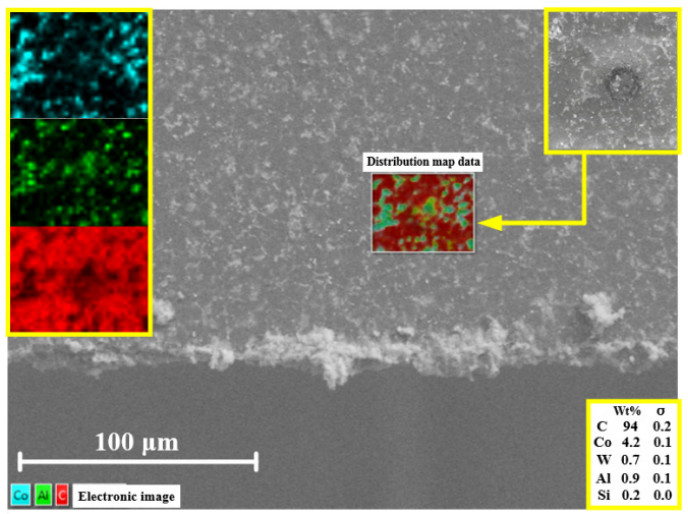
Figure 7. Energy-spectrum image of non-textured PCD tool near a crack. The SEM images of surfaces of the 15 textured PCD tools after the cutting was per- formed 20 times are shown in Figure 8. The large-area adhesion, tool wear, and surface scratches were significantly reduced in these cases. Observing the tool adhesion, the tex- tured tools with a smaller distance between the first row of pits and the main cutting edge ( d 1 = 25 µ m, 35 µ m) and relatively small pit spacing ( d 2 = 40 µ m, 60 µ m) exhibited better anti-adhesion (Figure 8b,c,g,h). When the texture spacing was too small ( d 2 = 20 µ m) or too large ( d 2 = 80 µ m and 100 µ m), the anti-adhesion effect tended to decrease. It was found that some micro-pits were blocked by residual materials, especially when they were close to the main cutting edge. By observing the locations of the blocked micro pits, it was possible to estimate the boundary of the sticking area. For example, in the case presented in Figure 8e ( d 1 = 25 µ m and d 2 = 60 µ m), the first row of pits was completely blocked, but the second row was not. The same phenomenon can also be observed in Figure 8c ( d 1 = 25 µ m and d 2 = 20 µ m). Comparing all the cases, the sticking area was estimated to be about 25–45 µ m from the main cutting edge. It was also noted that some of the pits were blocked by residual SiC particles rather than chips. These pits were mainly located in the sliding area. It was surmised that the SiC particles may play a supporting or rolling role between the chip and the texture during machining. The particle–chip interaction can increase the curvature of the chip and reduce the contact length of the chip, thereby reducing tool wear and adhesion.